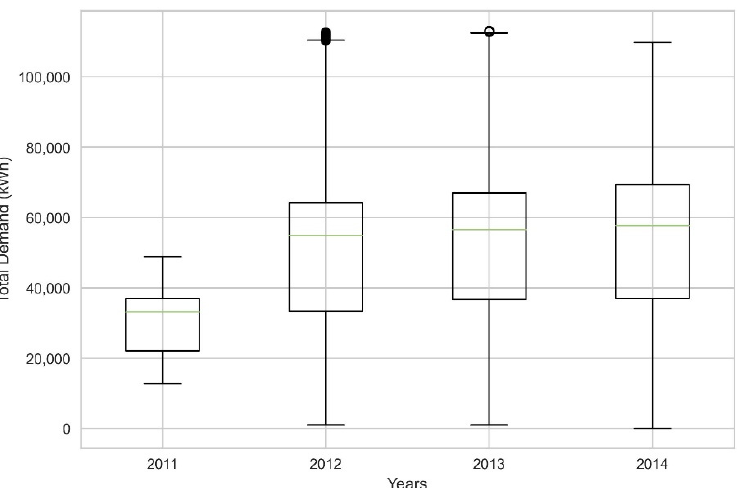
Figure 10. Boxplot of total yearly electricity demand.